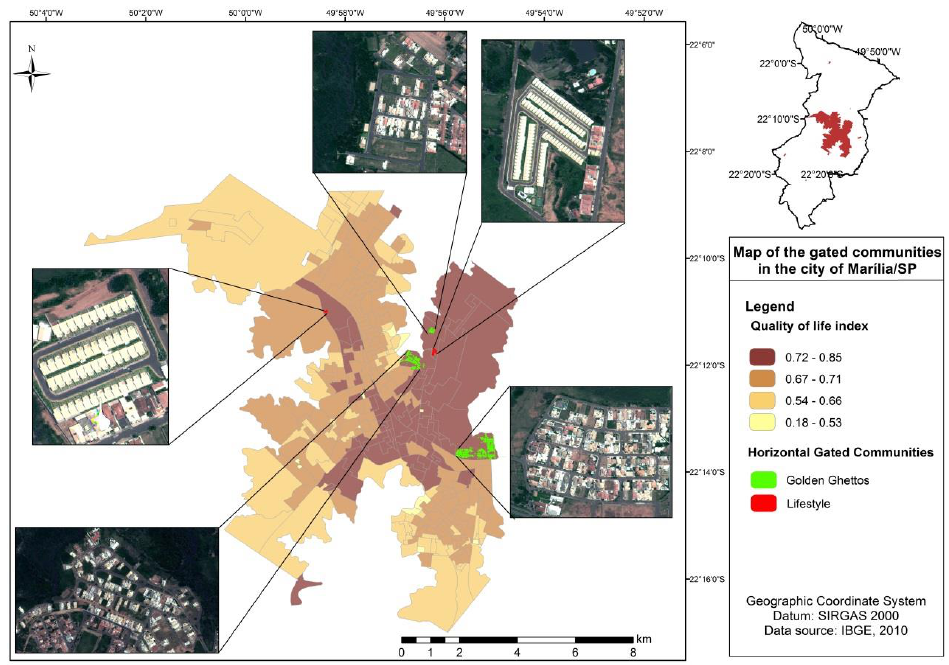
Figure 14. GC map categorized into lifestyle and golden ghettos.